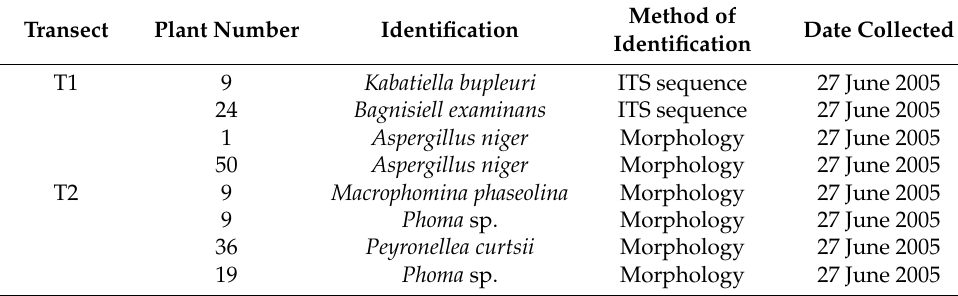
Table 2. Identification of isolates retrieved from transect plants in